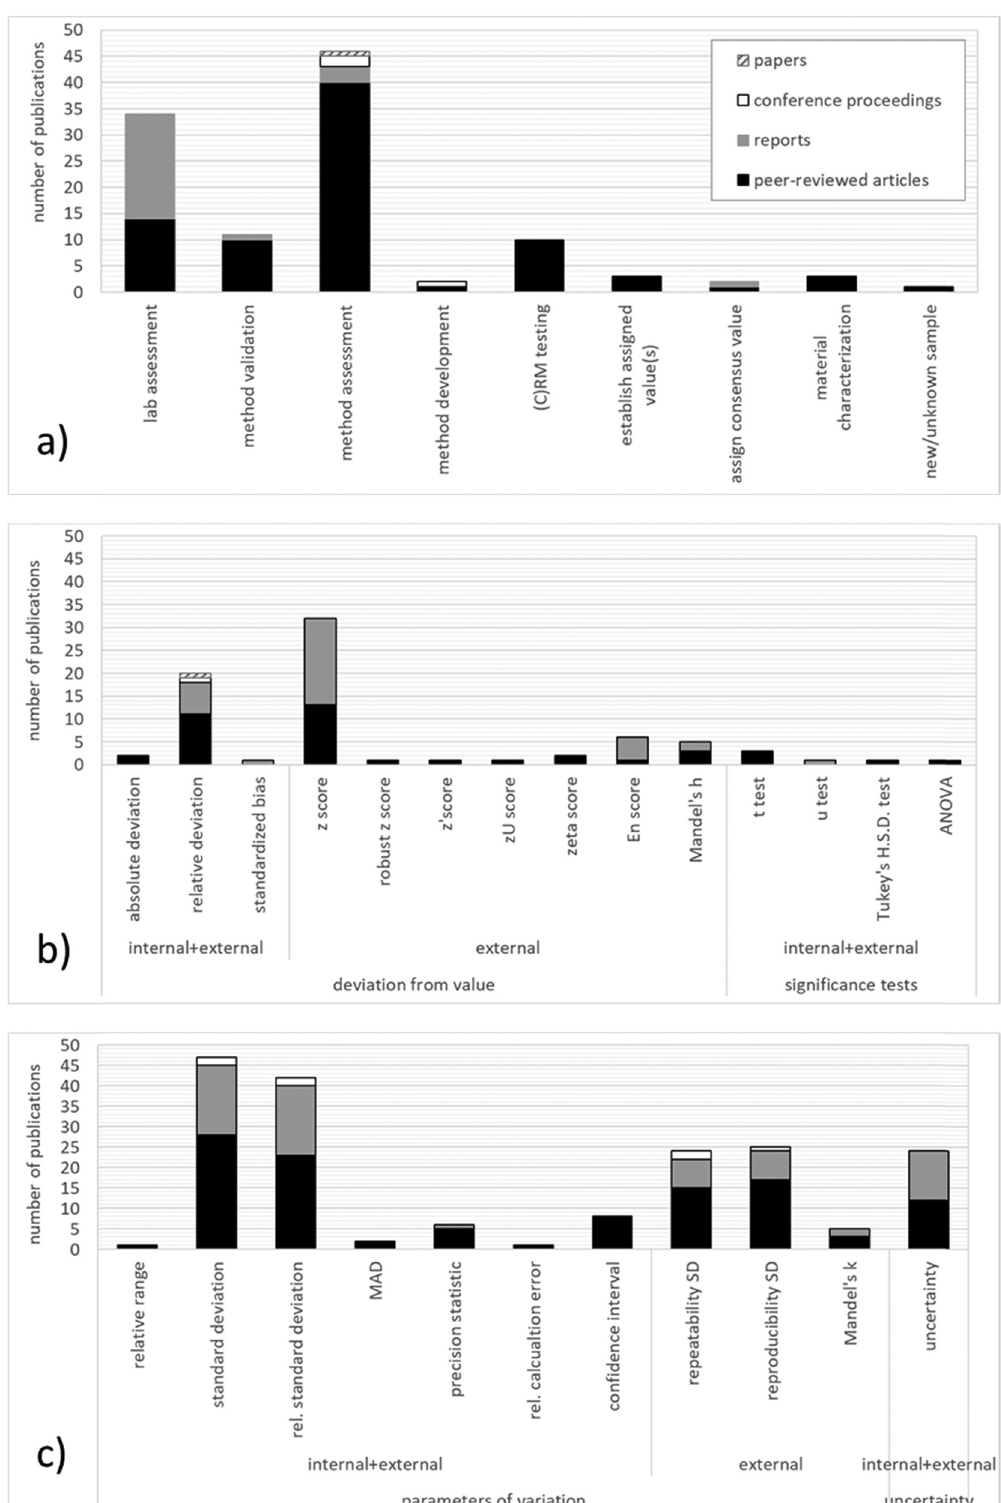
Figure 3: Overview of extracted information from all four publication types for ( a ) applied purposes per publication type, ( b ) use of TPP in all publications, and ( c ) use of PPP in all publications. The legend for the publication types is in the top right corner. Based on the review of refs [ 13 – 98 ]